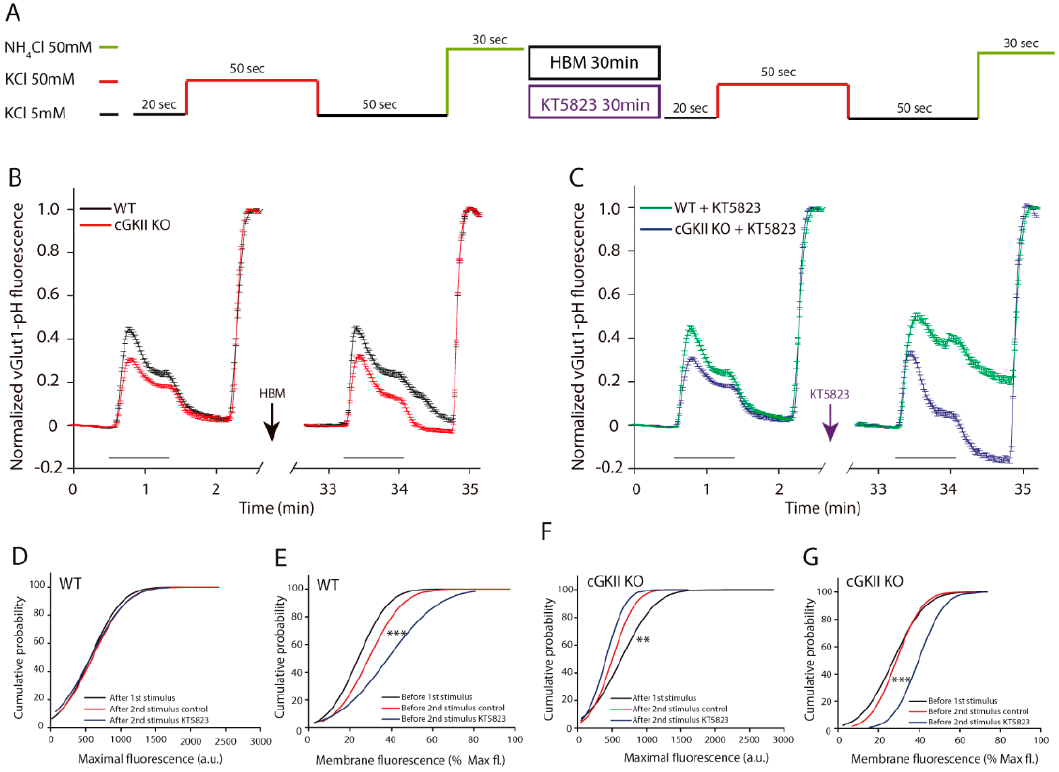
Figure 6. A double sustained stimulation protocol reveals important differences in the synaptic vesicle cycle of boutons from neurons lacking cGKII after KT5823 treatment: ( A ) Experimental protocol. ( B ) Mean traces of the increase in KCl-elicited vGluT1-phluorin fluorescence normalized to NH 4 Cl-elicited fluorescence for all the boutons analyzed from WT ( n = 207 boutons, 4 coverslips from three different cultures) or cGKII KO neurons ( n = 283 boutons, 5 coverslips from three different cultures) perfused with HBM between the two stimuli. ( C ) Mean traces of the increase in KCl-elicited vGluT1-phluorin fluorescence normalized to NH 4 Cl-elicited fluorescence for all the boutons analyzed from WT ( n = 156 boutons, 4 coverslips from three different cultures) or cGKII KO neurons ( n = 158 boutons, 4 coverslips from three different cultures) perfused with HBM containing KT5823 (1 µM) between the two stimuli. ( D ) Cumulative distribution of the maximal fluorescence (obtained by a brief exposition to NH 4 Cl) after the first or the second stimulus in boutons from the WT cells represented in panel B and C. ( E ) Cumulative distribution of the membrane steady state fluorescence expressed as a percentage of the maximal fluorescence before the first or the second stimulus ±KT5823 in boutons from the WT cells represented in panel B and C (*** p = 0.0056, 2nd stimulus vs. 1st stimulus, Mann–Whitney). ( F ) Cumulative distribution of the maximal fluorescence (obtained by a brief exposition to NH 4 Cl) after the first or the second stimulus in boutons from cGKII KO cells represented in panel B and C (** p = 0.0021, 2nd stimulus vs. 1st stimulus, Mann–Whitney). ( G ) Cumulative distribution of the steady state membrane fluorescence expressed as the percentage of the maximal fluorescence before the first or the second stimulus in boutons from cGKII KO cells represented in panel ( B , C ) (*** p = 0.0002, 2nd stimulus KT5823 vs. 2nd stimulus control or 1st stimulus, Kruskal–Wallis). The individual responses to the two stimuli of the boutons analyzed were also quite heterogeneous, although those of the WT and cGKII KO cells could be grouped into three types of profile (termed A, B and C), either perfused with HBM alone or HBM plus KT5823 (Figure 7A). In profile A, there was a rapid increase in fluorescence upon stimulation due to the exocytosis, followed by a decay in fluorescence due to the brief compensatory endocytosis until a steady-state was reached and maintained until the end of the stimulus. The time constants ( τ ) to reach the steady-state were similar for boutons from both WT and cGKII KO cells ( τ 1 ; Table 2). This steady-state was the